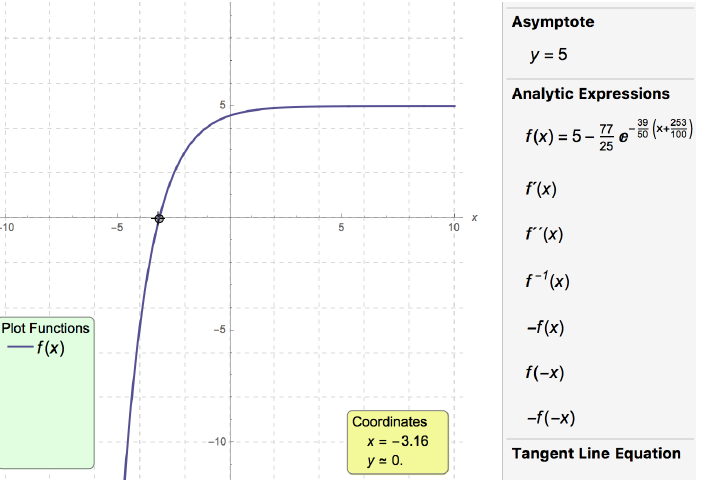
Figure 19. Image that illustrate part of another evaluation task: graphical representation of the inverse function whose function is drawn and analytical determination of that function.